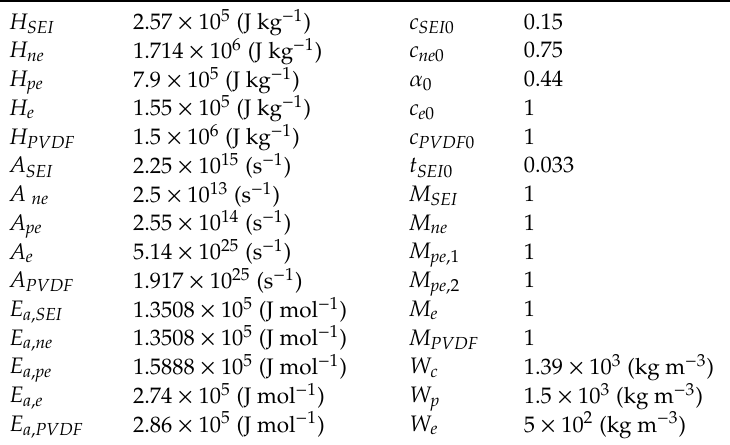
Table 1. Physical and kinetic parameters for abusive